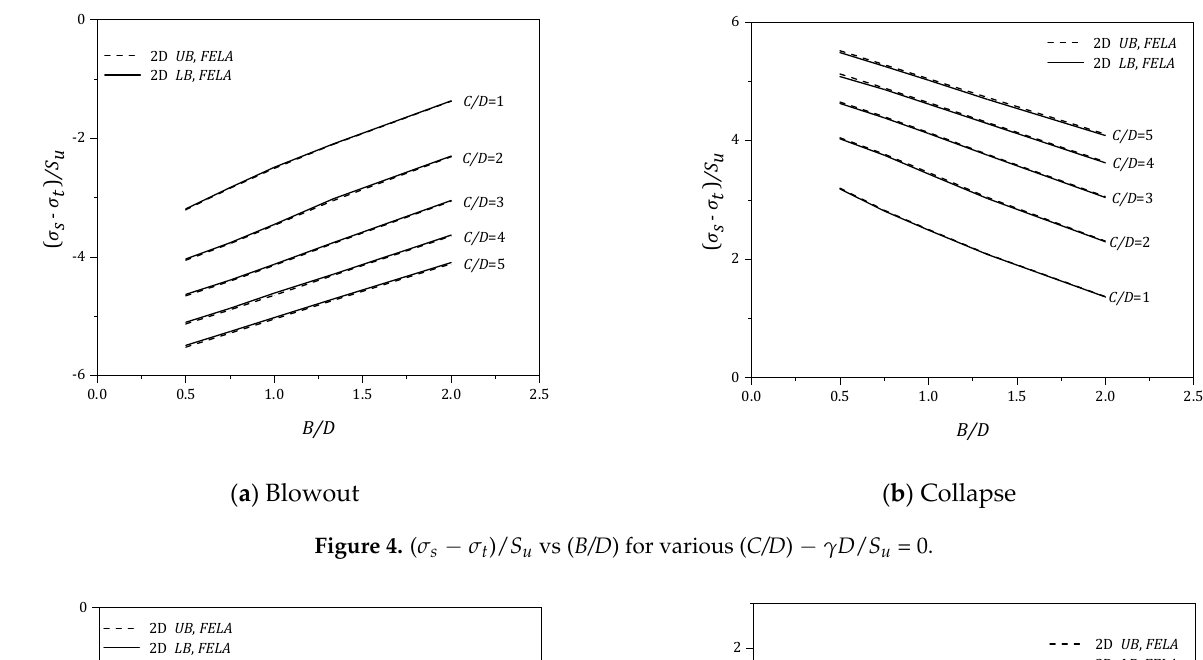
Figure 4. ( σ s − σ t )/ S u vs ( B/D ) for various ( C/D ) − γ D / S u = 0.